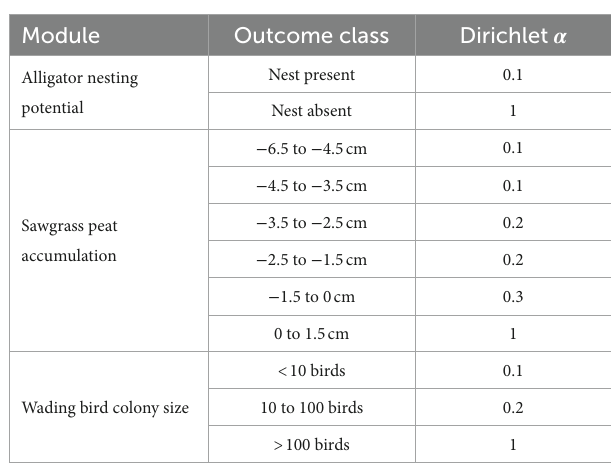
TABLE 2 Dirichlet shape parameters ( α ) assigned to each outcome for the alligator nesting potential, sawgrass peat accumulation, and wading bird colony size modules in